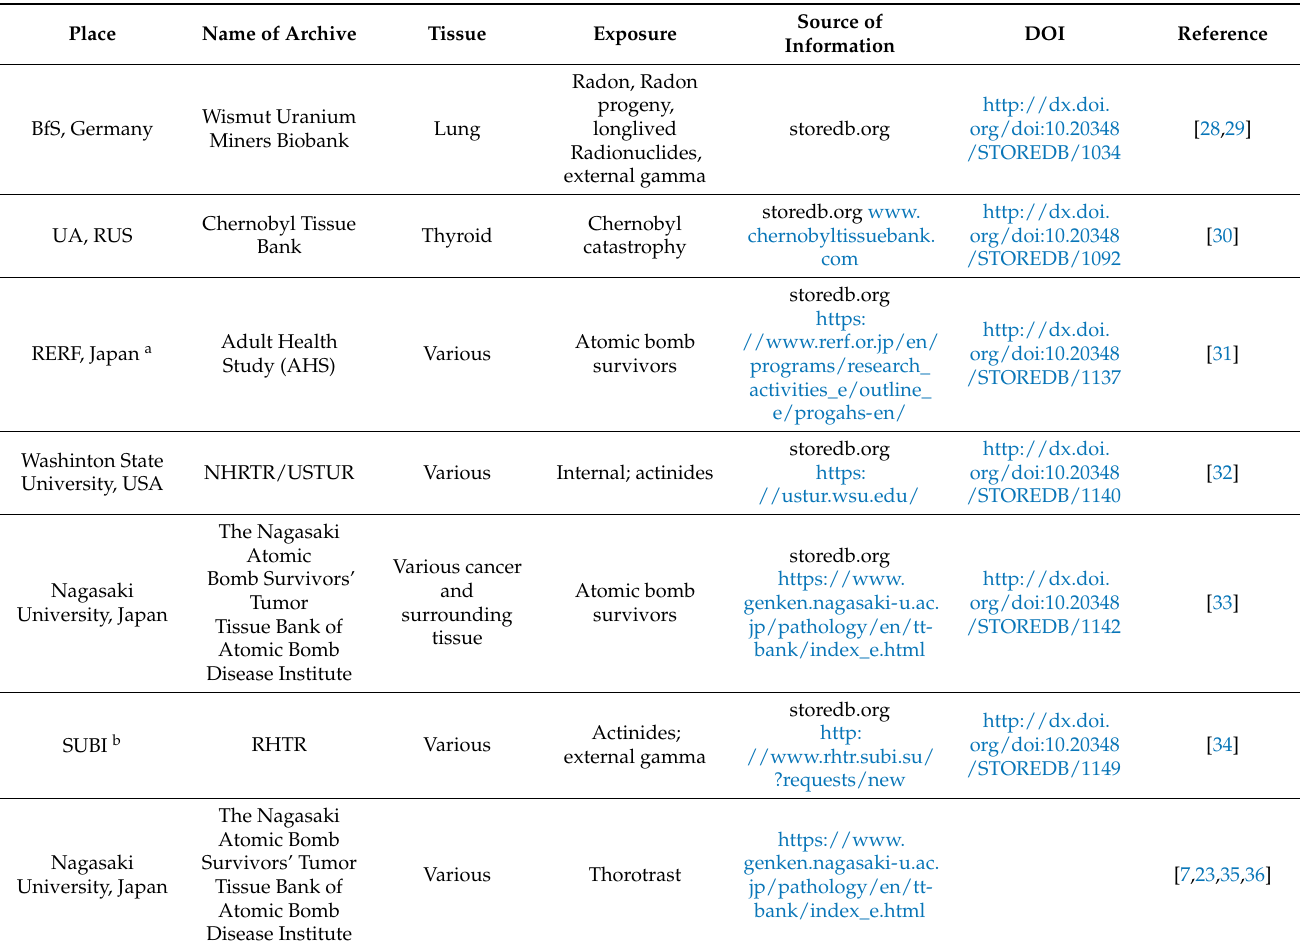
Table 2. The FFPE human tissue listed in the STORE DB and/or available in the radiobiological